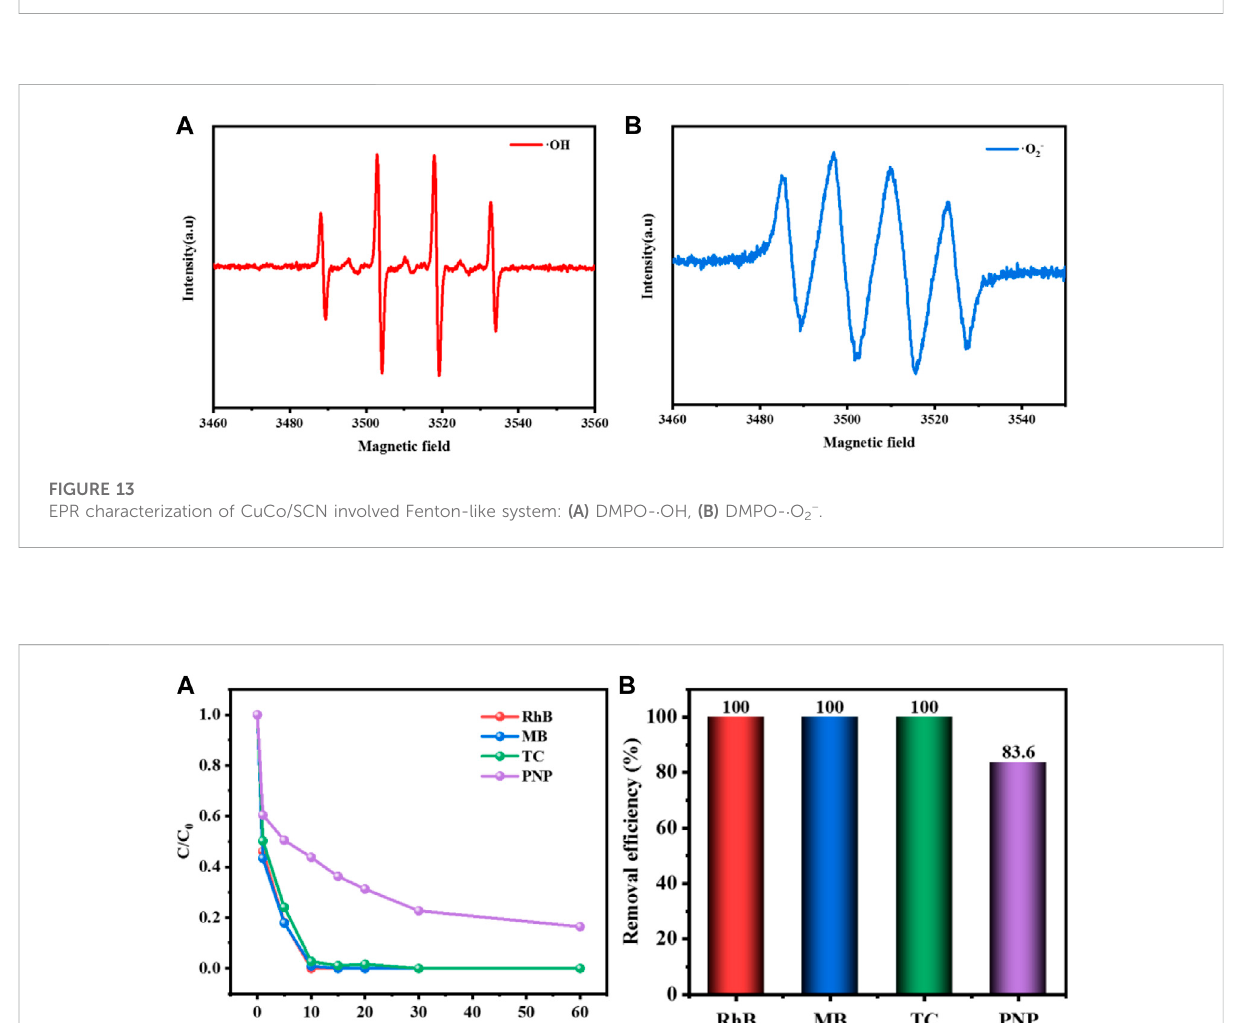
FIGURE 12 (A) Effect of the amount of isopropanol on MO removal ef fi ciency, (B) Fluorescence intensity of 7-hydroxycoumarin during the reaction.